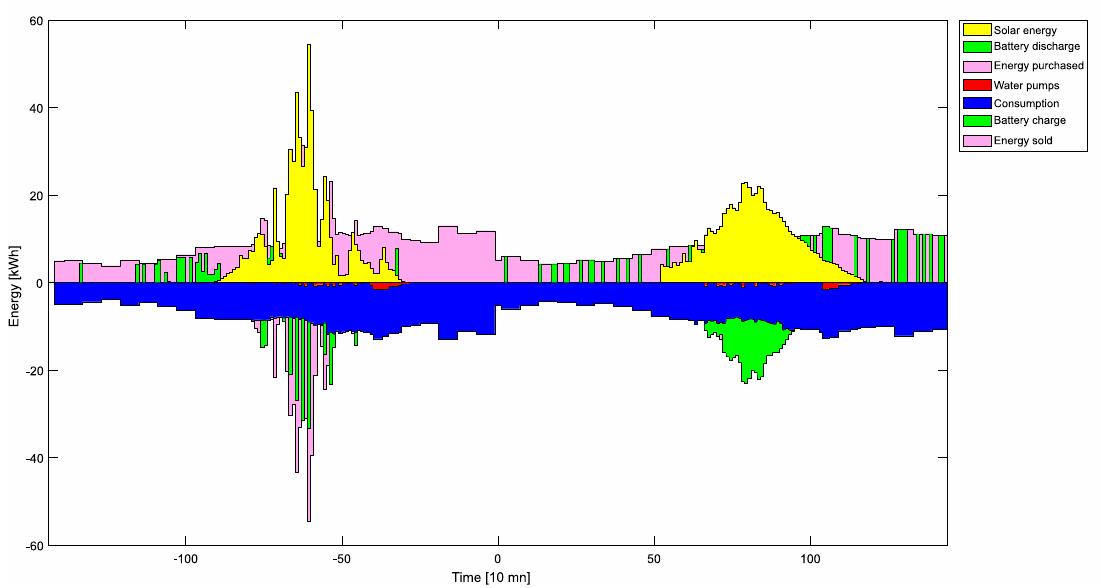
Figure 6. EWMS operations for microgrids for the baseline scenario ( S 0